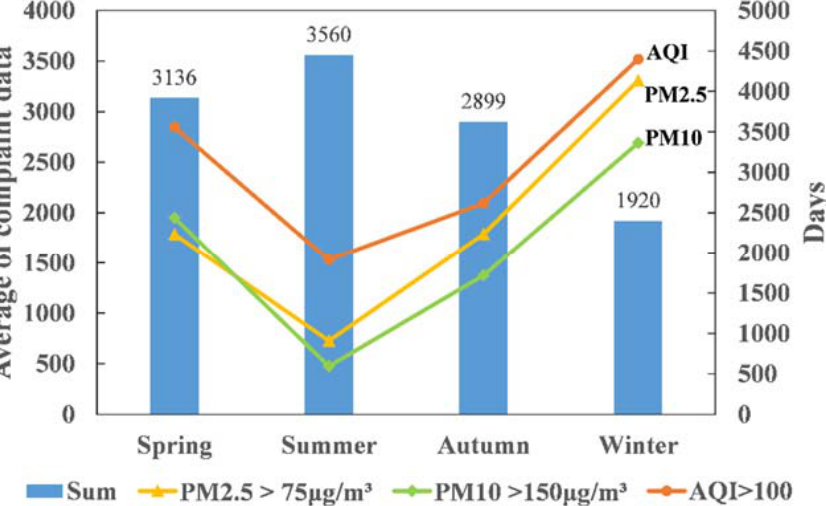
Figure 2. The interannual changes in the total number of air pollution-related complaint data and the number of days that PM2.5 and PM10 exceeded the standard in 17 cities in Shandong Province from 2012 to 2018.